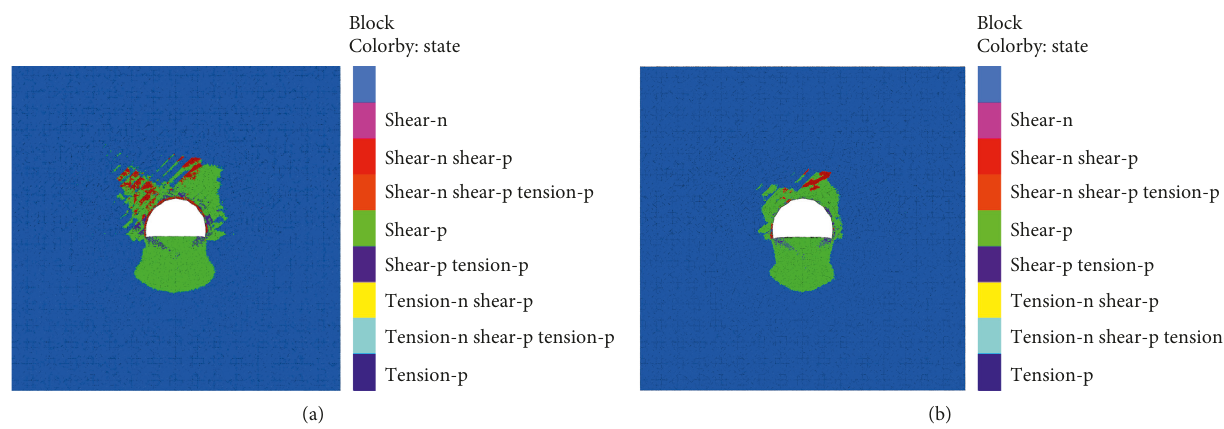
Figure 18: Distribution characteristics of the plastic zone of the surrounding rock. Surrounding rock distribution of the plastic zone with (a) the steel anchor support and (b) the anchor cable support.